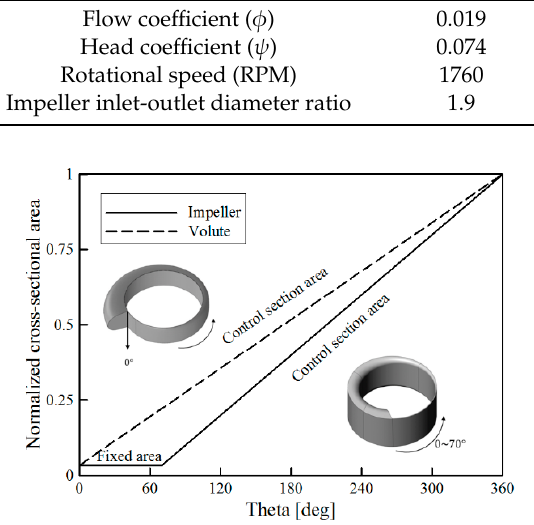
Figure 2. Cross-sectional area distributions along the theta angle of impeller and volute.